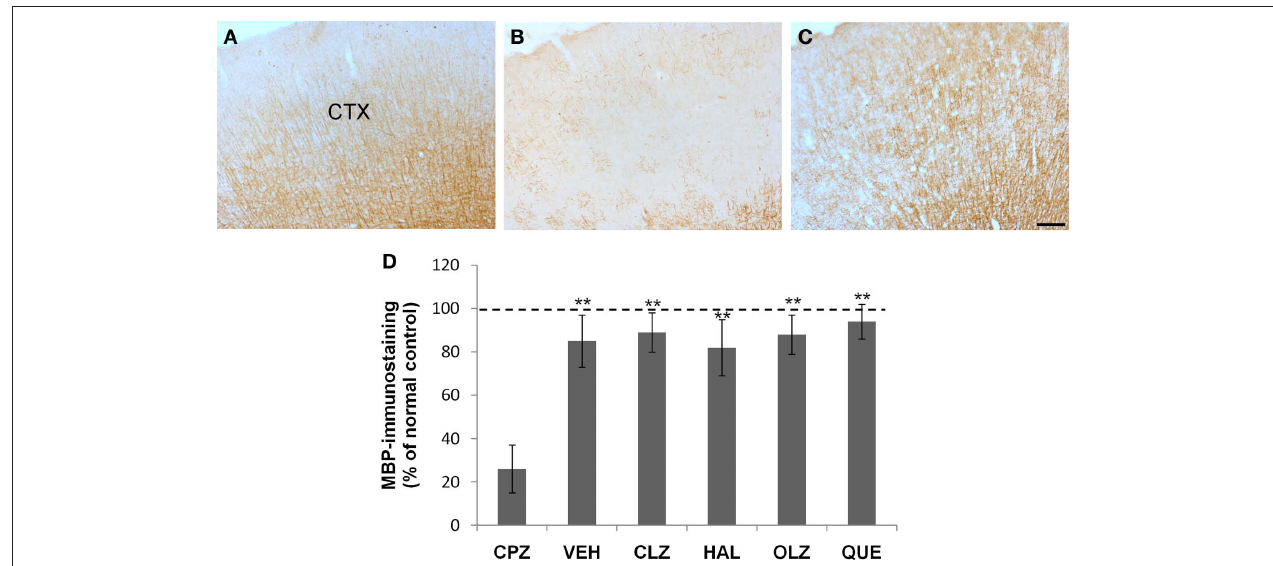
mouse treated with VEH during the 3-week recovery period after CPZ withdrawal. (D) The quantitative data (mean ± SEM; n = 5/group). The dotted line indicates the value of the CNT group, which was significantly higher than the CPZ group. ** p < 0.01, compared to the CPZ group. The scale bar in the image (C) represents about 300